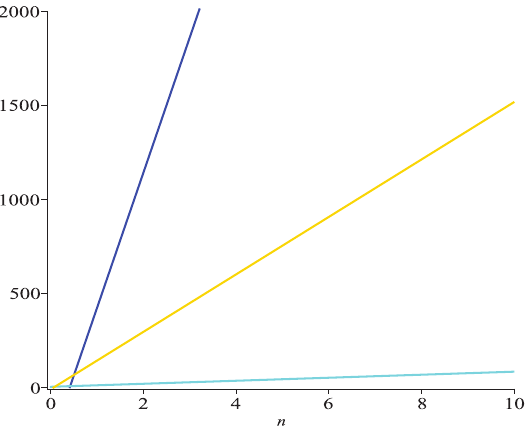
(G), RR (G), and SSD (G) are a a